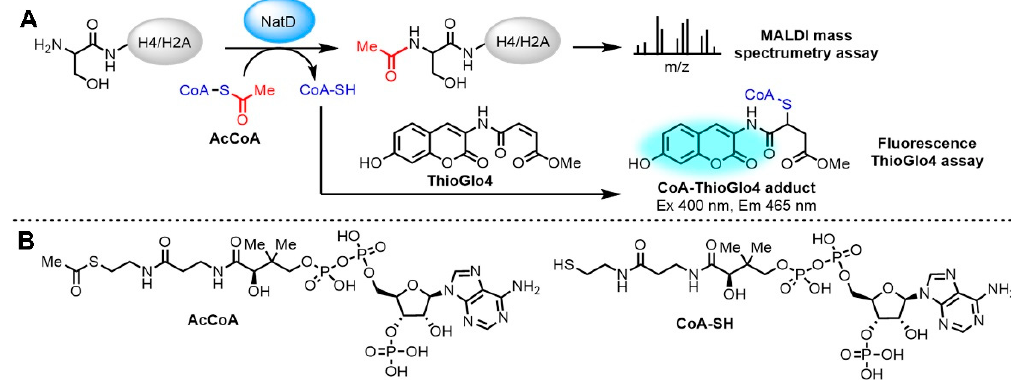
Figure 1. N -terminal acetyltransferase D (NatD) catalyzed N -terminal acetylation reaction. ( A ) Primary fluorescence ThioGlo4 and MALDI mass spectrometry assays. ( B ) Selected structures of assay